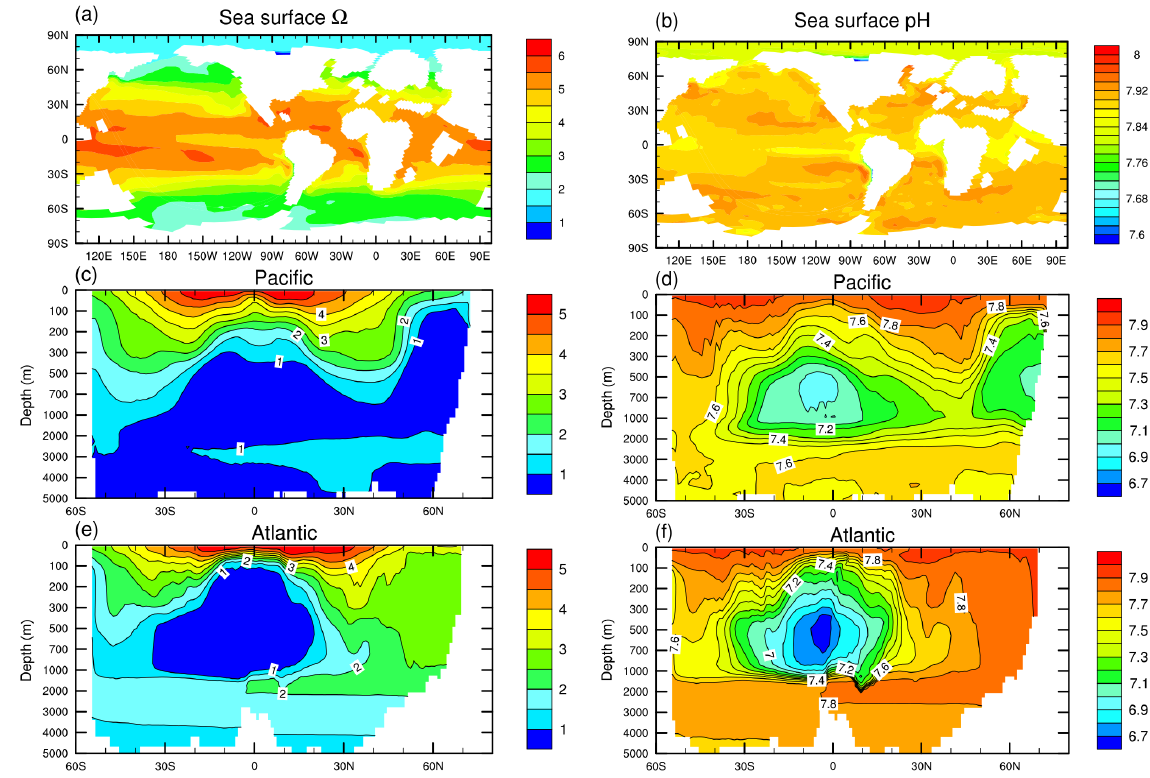
Figure 11. (cid:127) (left) and pH (right) for the surface (a, b) , Pacific (c, d) , and Atlantic (e, f) averaged meridional crosscuts. Note the nonlinear vertical axes, used to zoom in on the upper ocean